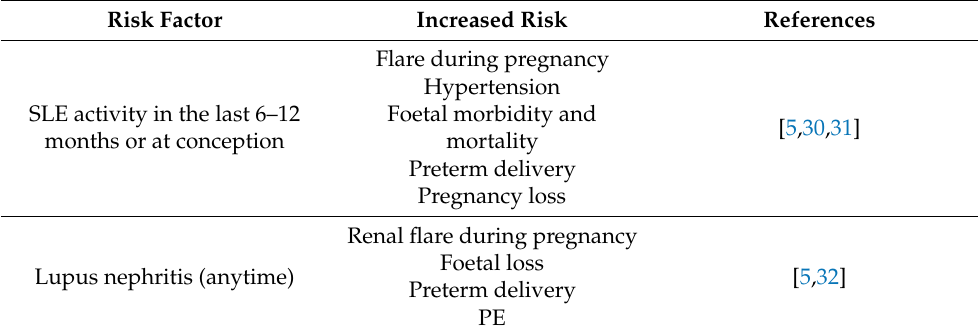
Table 1. Prognostic implications to be discussed at a preconception